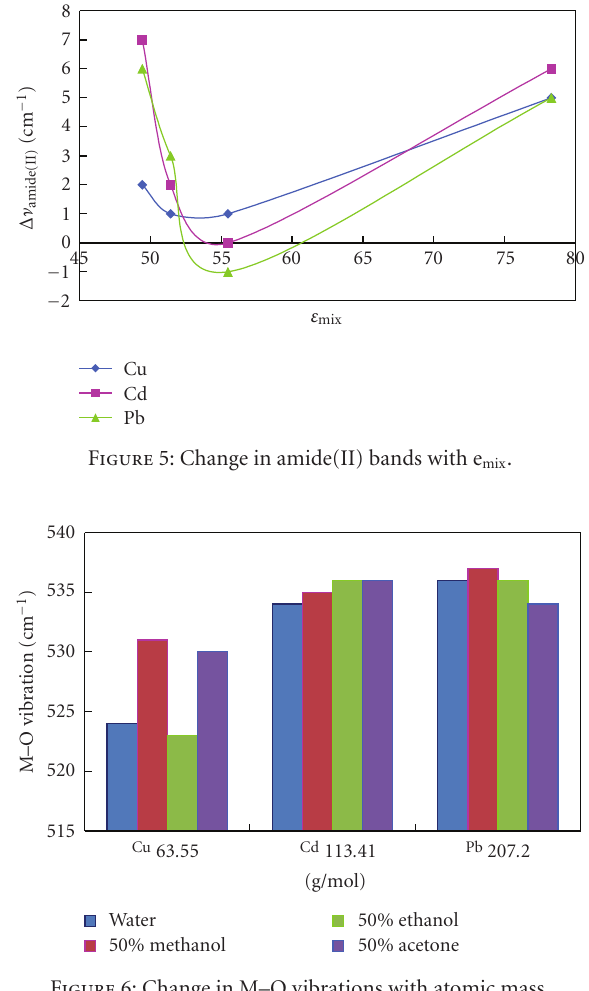
trend was observed in shifts of amide(II) bands in Figure